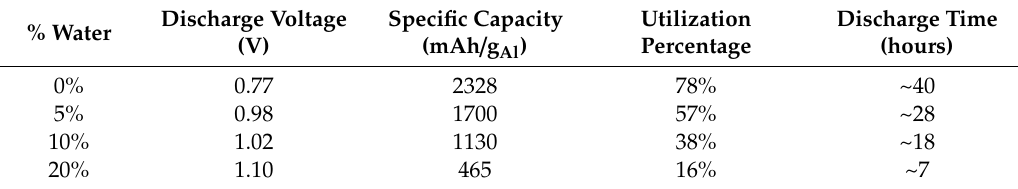
Figure 6. ( a ) Galvanostatic discharge profiles of the batteries using 3 M KOH in methanol solution anolytes containing di ff erent ratios of water (0%, 5%, 10%, and 20% (v / v)) and a circulation rate of anolyte of 15 mL / min at discharge current density of 10 mA · cm − 2 . ( b ) Galvanostatic discharge profiles of the batteries using 3 M KOH anhydrous methanol anolyte with di ff erent electrolyte circulation rates at discharge current density of 10 mA · cm − 2 . Table 4. Summary of the specific capacity, utilization percentage, and discharge time of the batteries using 3 M KOH in methanol solution anolytes containing di ff erent ratios of water (0%, 5%, 10%, and 20% (v / v)) and a circulation rate of anolyte of 15 mL / min at discharge current density of 10 mA · cm − 2